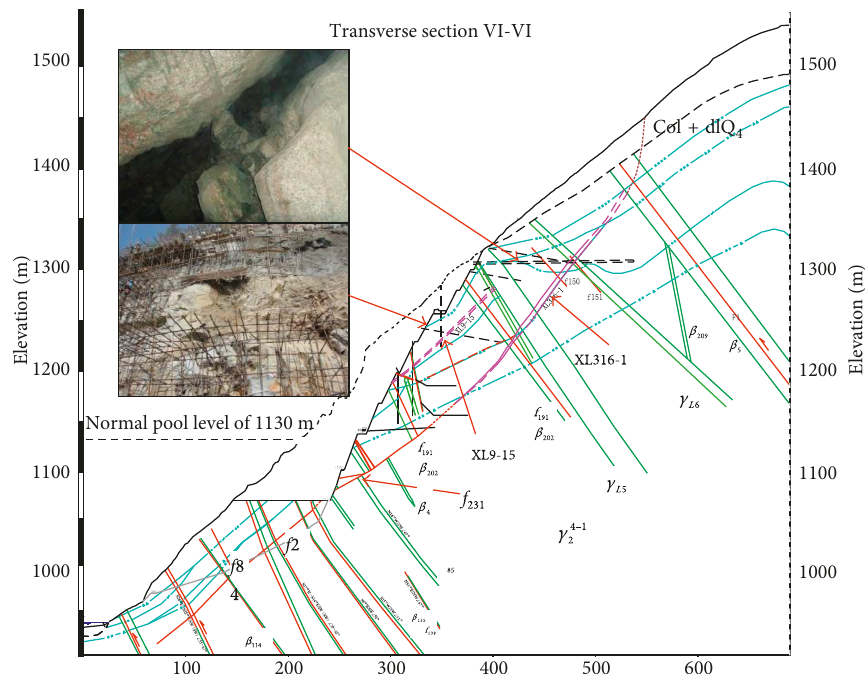
Figure 2: Geomorphic layout of the typical transverse section VI-VI of the right bank slope